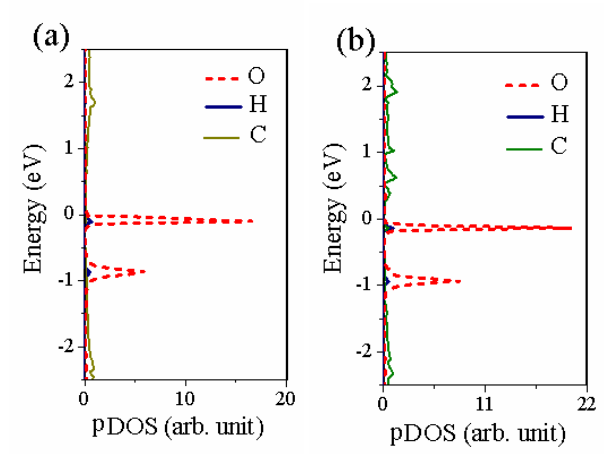
Fig. 4. pDOS of (a) defect free and (b) defective graphene with one hydrogen peroxide per